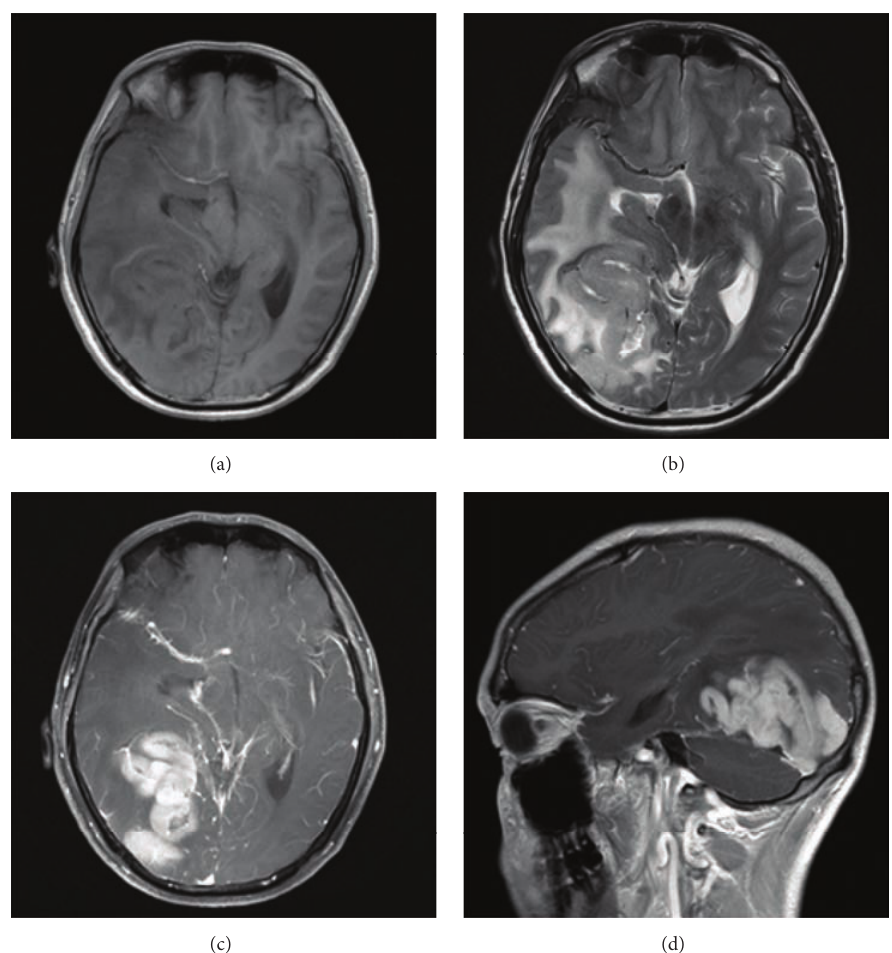
Figure 2: MR images from the same patient as shown in Figure 1. The mass was isointense on T1WI and slightly hyperintense on T2WI. Contrast-enhancement T1WI images showed prominent homogeneous enhancement. The tumor was buried in the cortical sulci without any dural